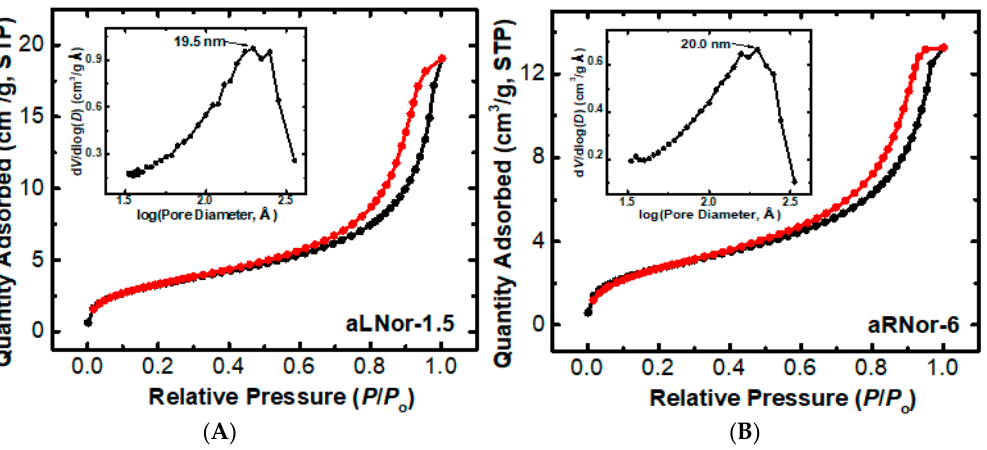
Figure 11. Representative N 2 -sorption diagrams for aliphatic (aLNor-1.5) ( A ); and aromatic (aRNor-6) ( B ). Insert shows the BJH distribution.